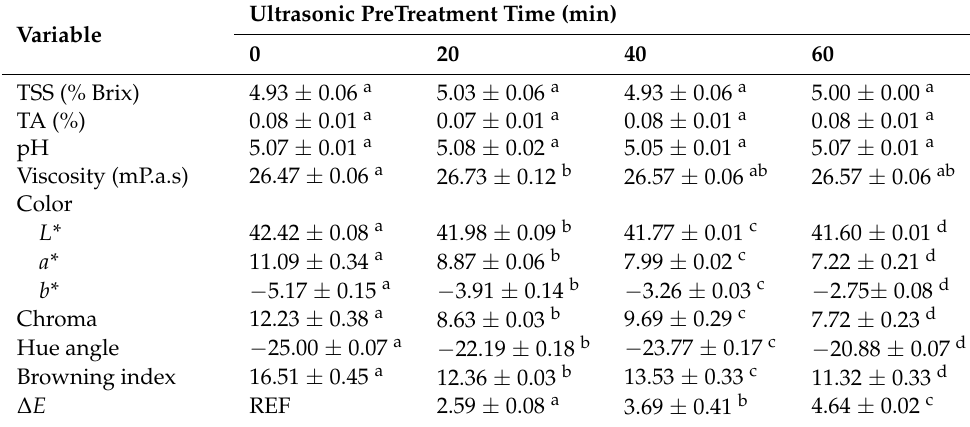
Table 1. Total soluble solids, titratable acidity, pH, viscosity, and